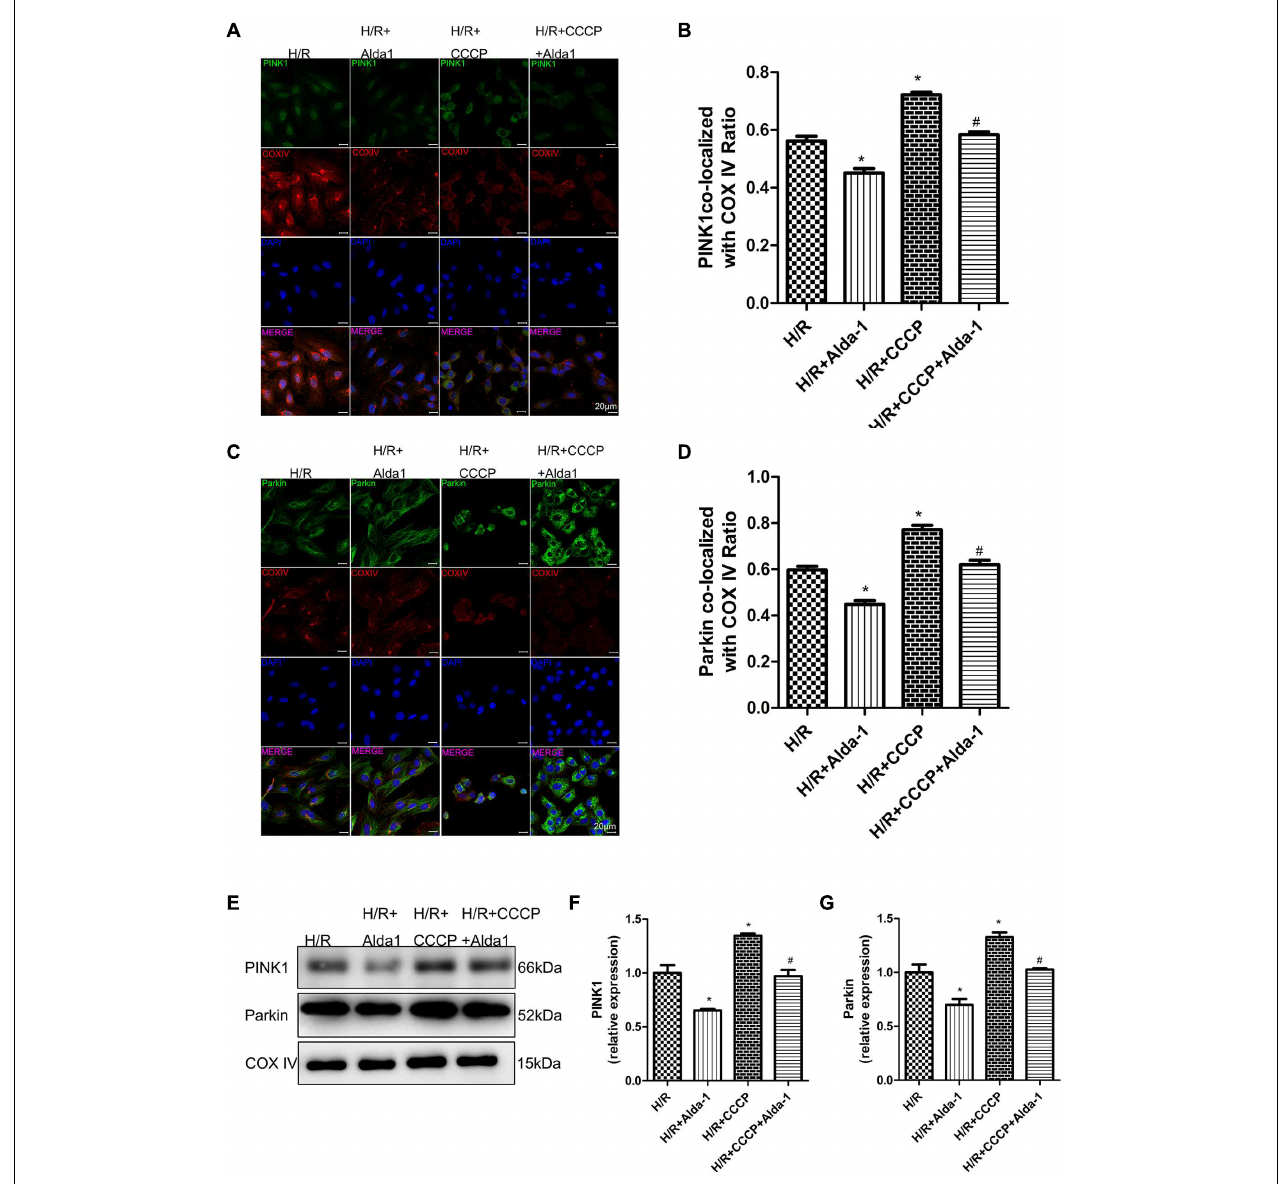
FIGURE 8 | Effect of CCCP on mitophagy in H/R-treated H9C2 cells. (A) Representative immunostaining of co-localization of PINK1 and COX IV. (B) Co-localization ratio of PINK1 and COX IV ( P < 0.0001, One-way ANOVA). (C) Representative immunostaining of co-localization of Parkin and COX IV. (D) Co-localization ratio of PINK1 and COX IV ( P < 0.0001, One-way ANOVA). (E) Representative gel blots of expression of PINK1, Parkin and COX IV (mitochondrial loading control). Quantification analysis of (F) PINK1 expression, (G) Parkin expression ( P < 0.0001, P = 0.002, One-way ANOVA). Representative images are shown (magnification, 630 × ). Scale bar: 20 µ m. Representative immunostaining of 3 independent experiments. Data are mean ± SD from 3 independent experiments. ∗ P < 0.05 vs. CON; # P < 0.05 vs. H/R +